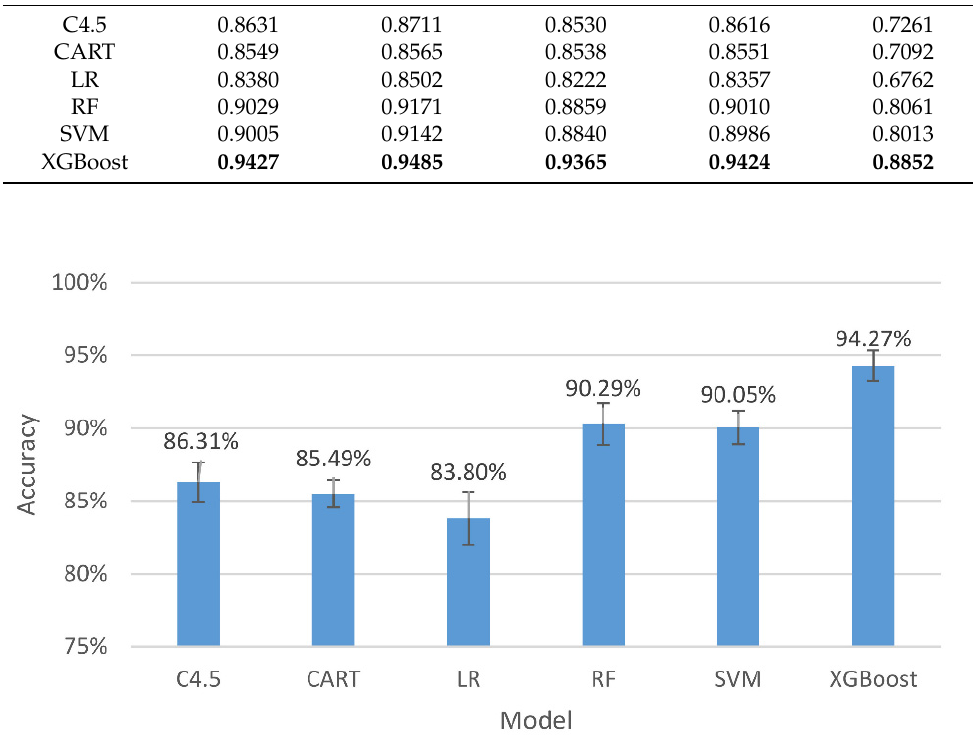
Figure 5. The accuracy and 95% confidence intervals of the generalizing models for the two-level classification (high and low stresses).